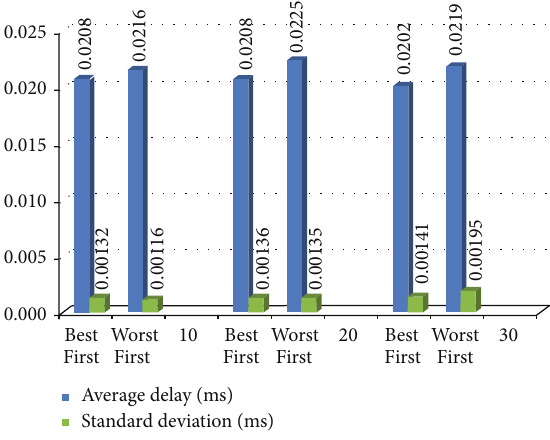
Figure 12: The result of multinode